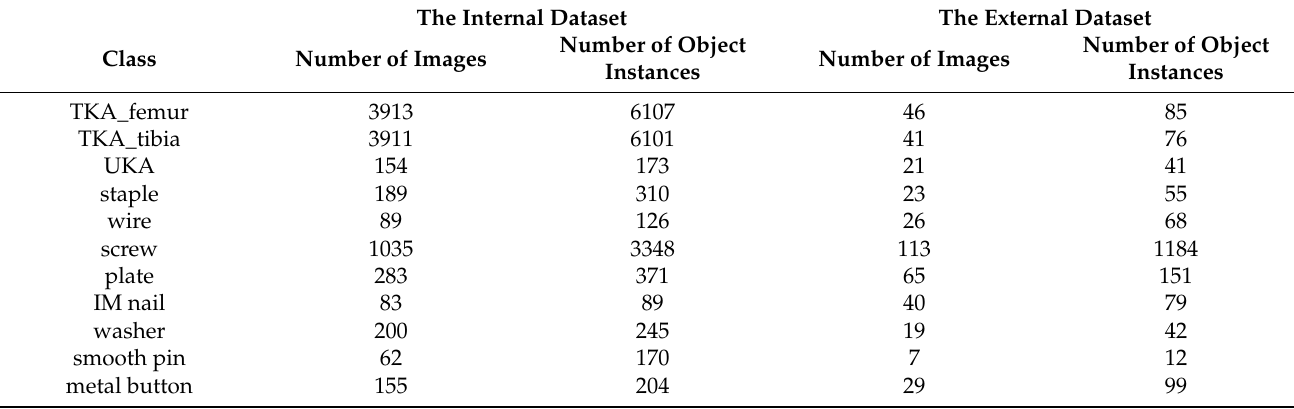
Table 1. The number of images and instances by class in internal and external dataset. The Internal